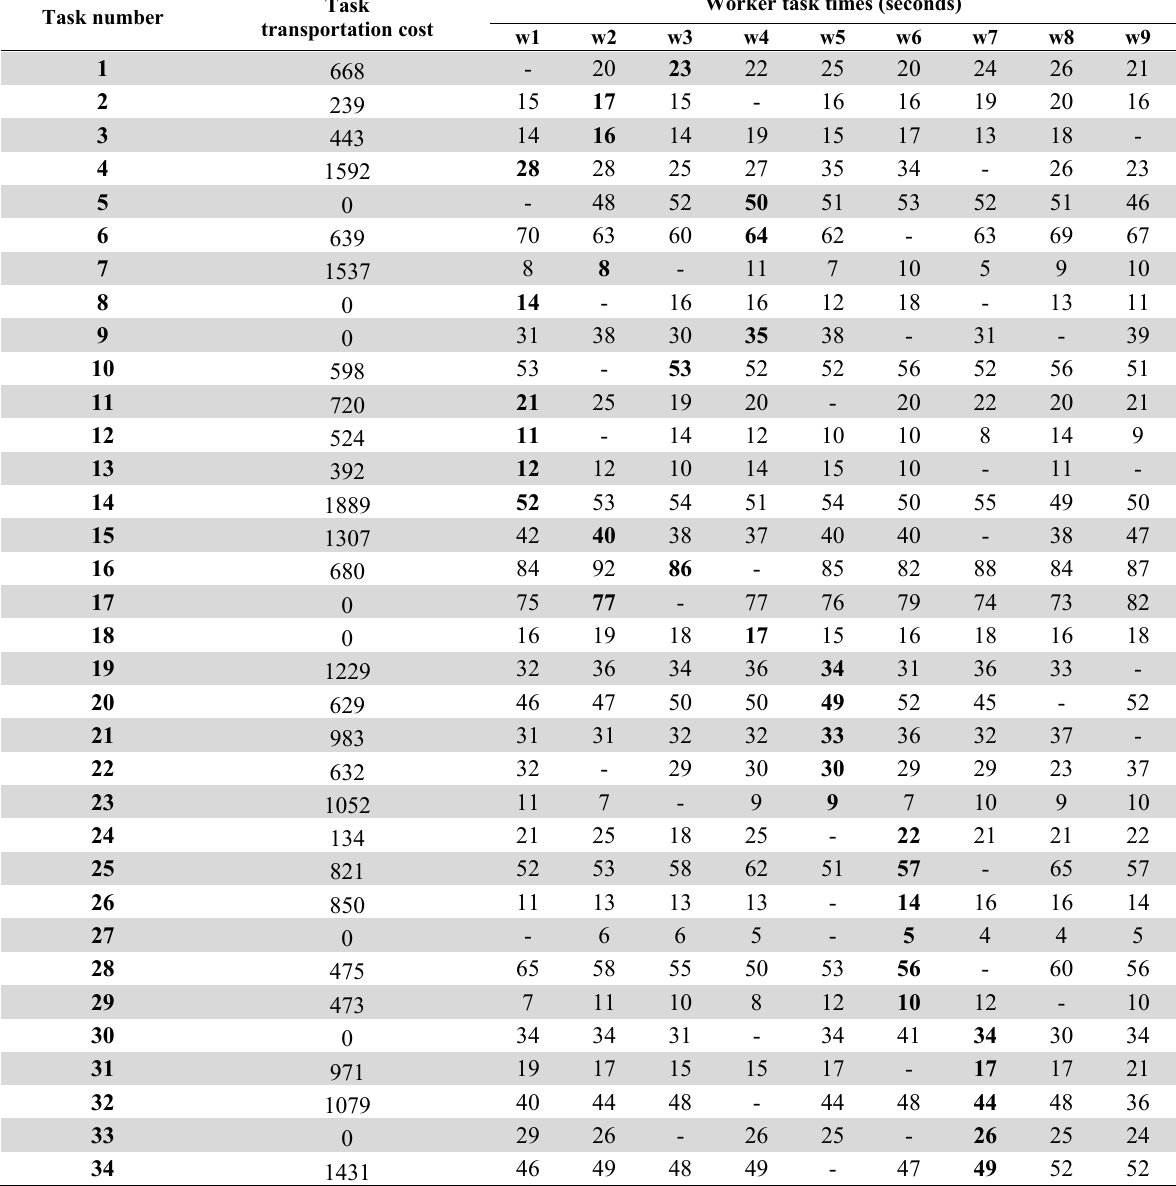
Kitting data: Technical move count variables and values of each task. These data are generated after a detailed analysis of technical drawings and assembly lines which are used in OCRA ergonomic